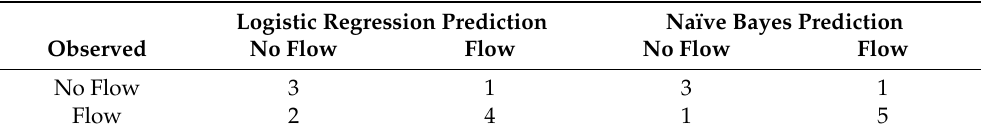
Table 5. Confusion matrices for the logistic regression and naïve Bayes algorithms using the features derived from Study 1 for prediction of flow in a new